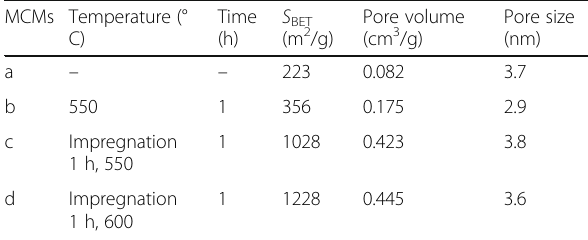
Table 1 The parameters of MCMs obtained at different reaction